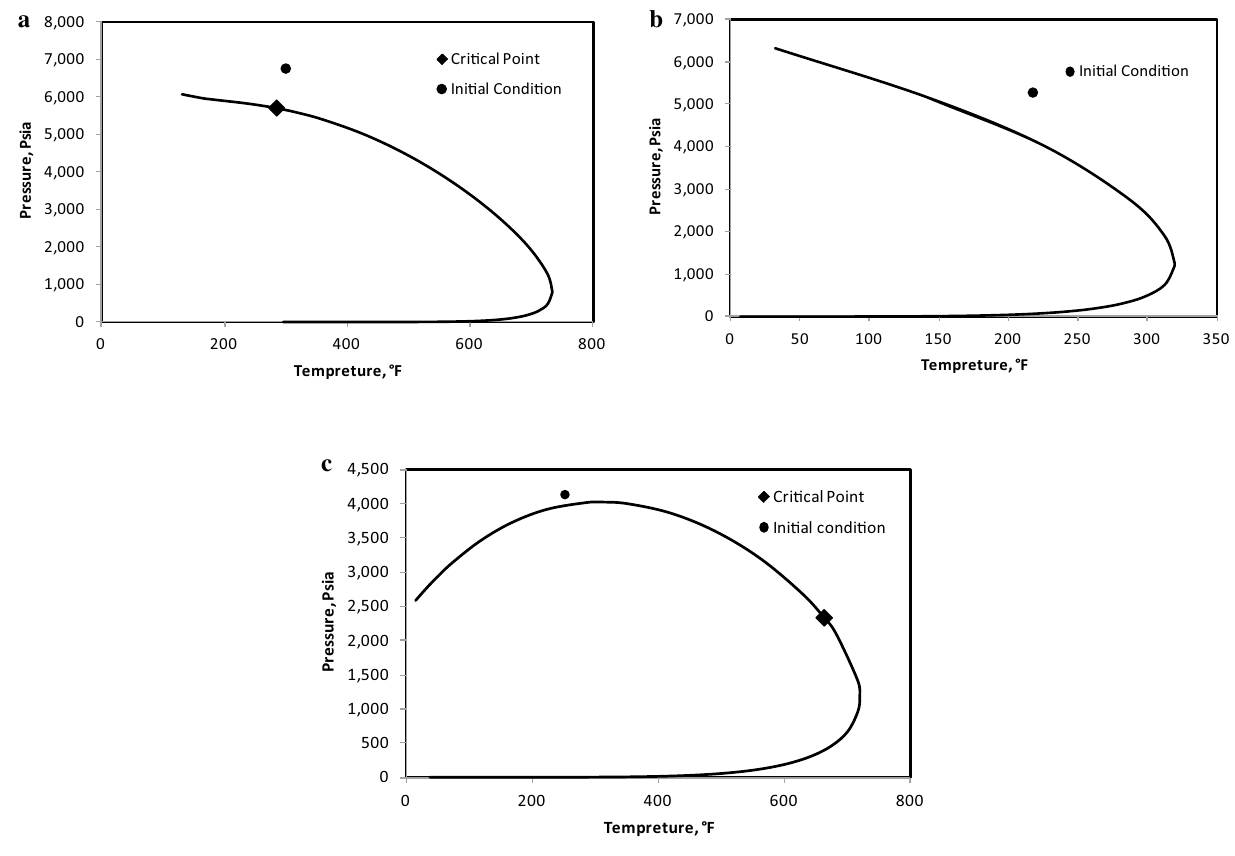
Fig. 3 a Two-phase envelope, gas condensate sample, reported by Ghorayeb and Firoozabadi (2000). b Two-phase envelope, gas condensate sample, selected from a supergiant reservoir (Osfouri et al. 2014). c Two-phase envelope, volatile oil sample, reported by Hamoodi et al. (1996)